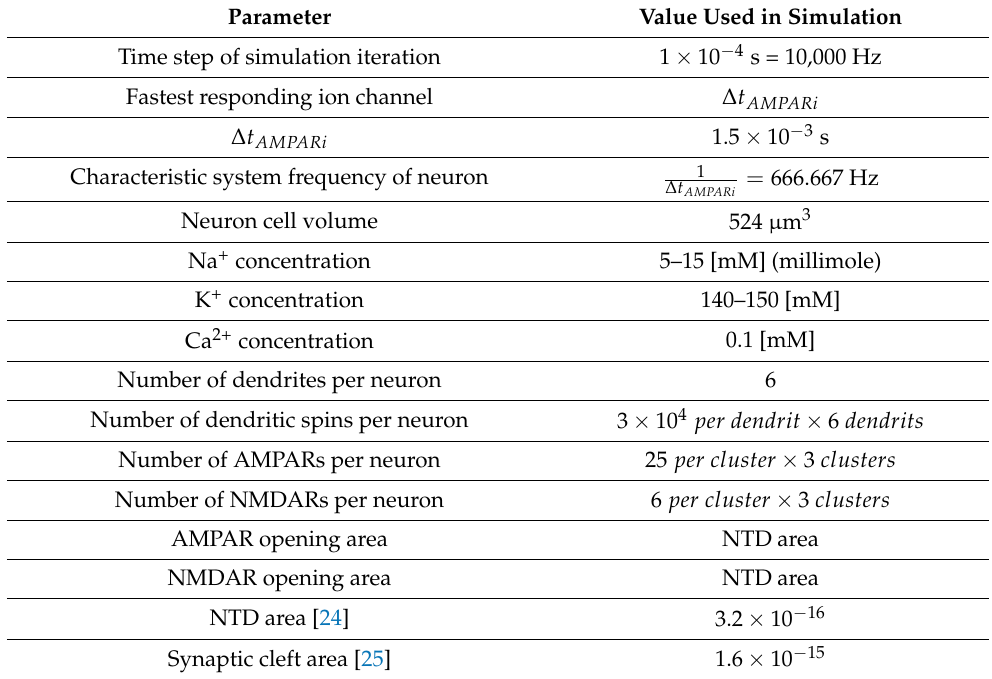
Table 2. Parameters of individual neurons. Parameter Value Used in